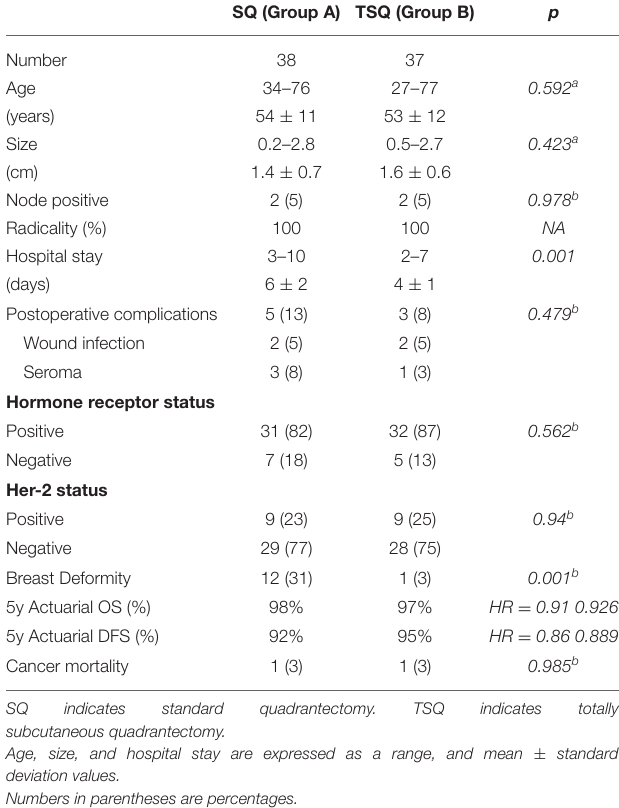
subcutaneous quadrantectomy.